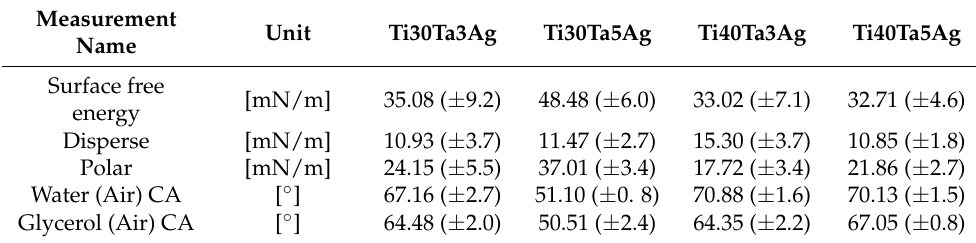
Table 4. The wettability data for the Ti-Ta-Ag hot-pressed